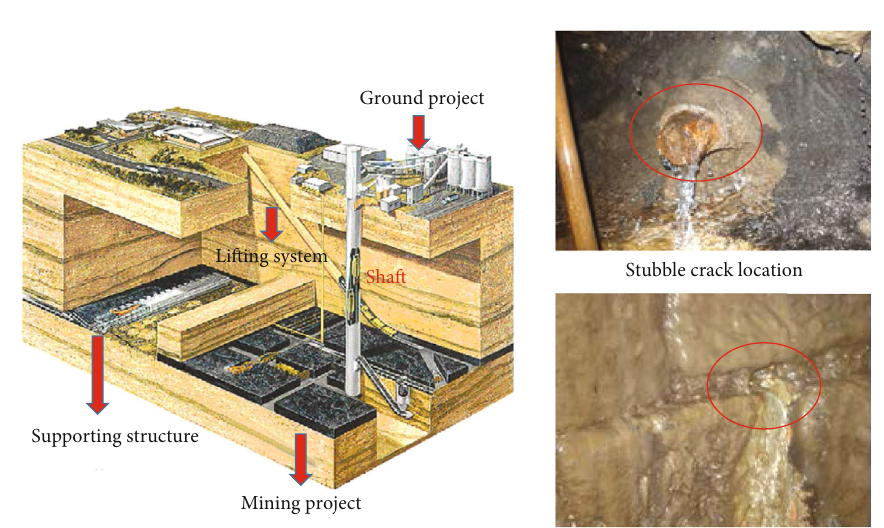
Figure 2: The shaft water